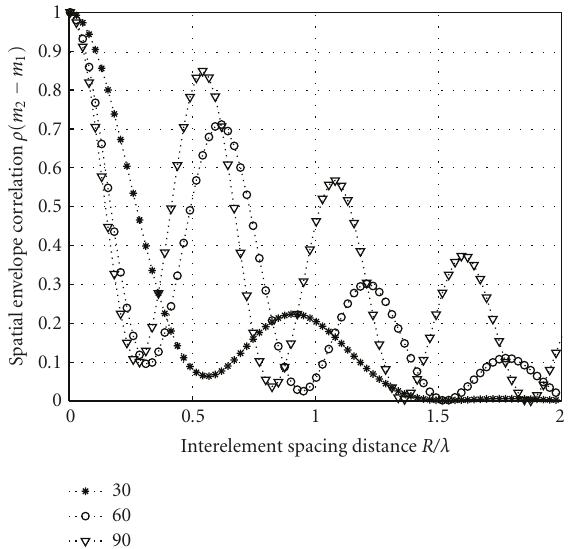
Figure 7: Spatial correlation for the 3-component VMF mixture. Note that the 3 clusters are located in di ff erent places and that their (prior) contributions are the same.